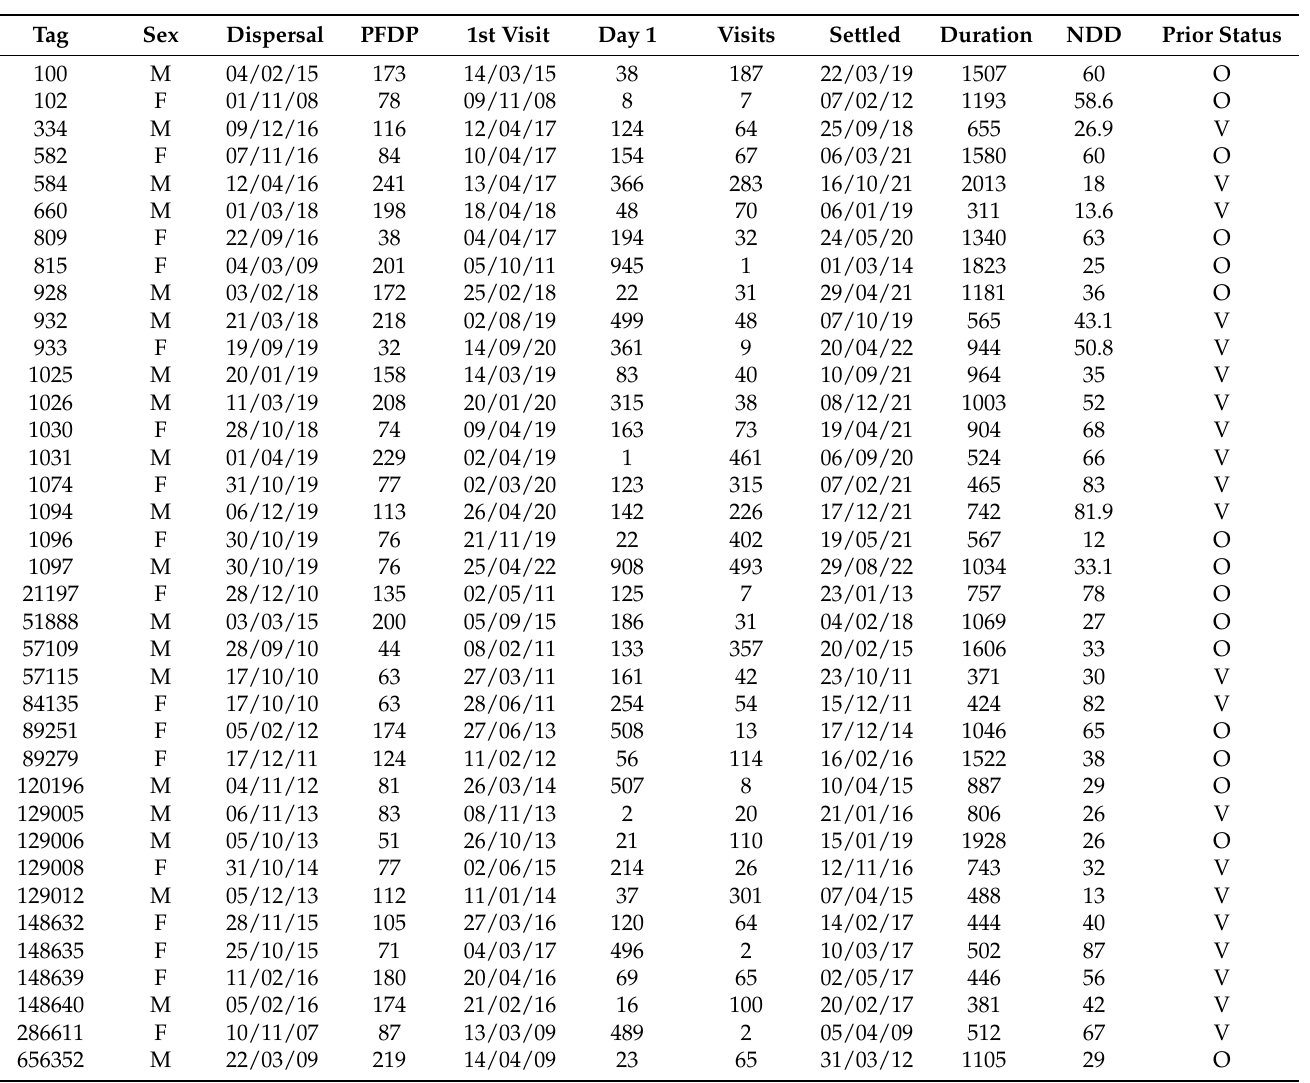
Table 1. Raw data used in analyses. Tag = Tag ID, Sex (M = male, F = female), Dispersal = date of dispersal (end of PFDP: d/m/y), PFDP = duration of PFDP (d), 1st visit = date of first visit to future range, Day 1 = 1st visit to future range (d) where 0 = start of dispersal, Visits = number of unique dates (d) on which the settled range was visited, Settled = date the bird settled (d/m/y), Duration = natal dispersal duration (d) (number of days to settlement from the start of dispersal, day 0), NDD = Distance from natal site to future range (km), Prior Status = status of the future range prior to settlement (O = occupied, V =